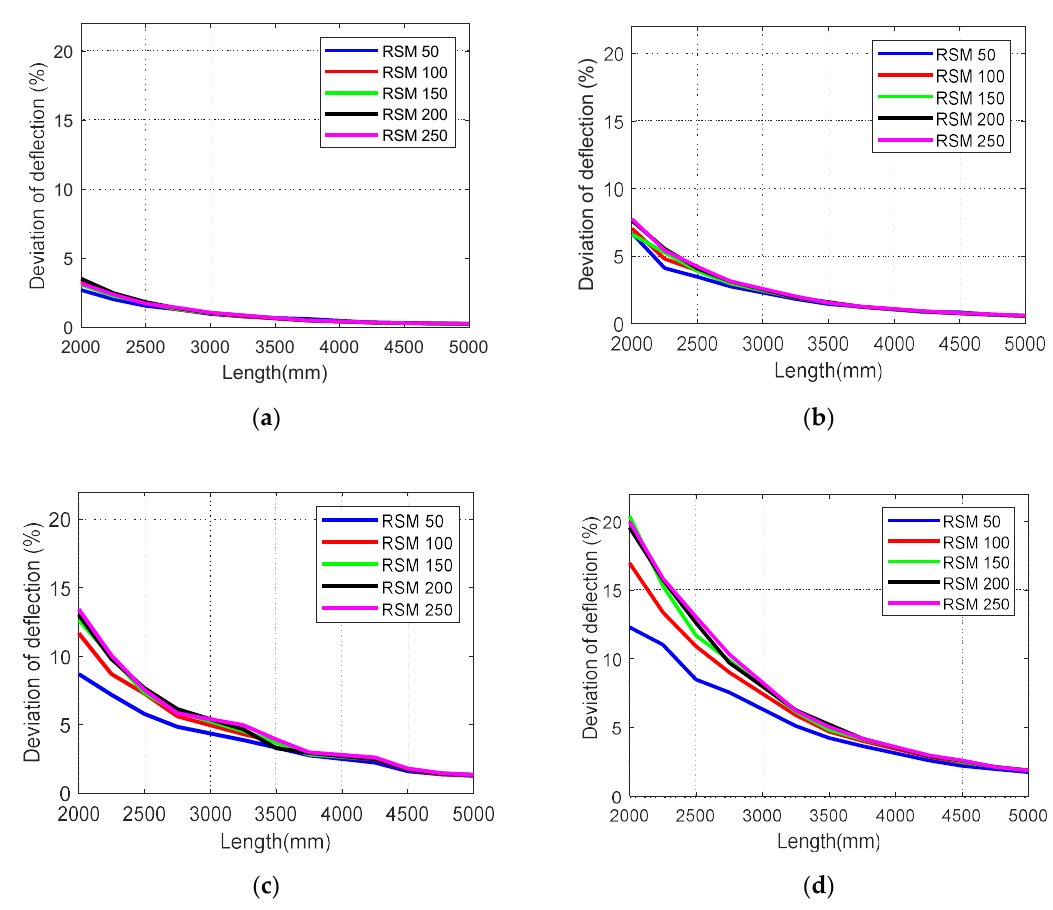
Figure 7. Comparison between FE predictions for CLT deflections vs. analytical predictions using Timoshenko method: ( a ) 90 mm thick CLT panels, ( b ) 120 mm thick CLT panels, ( c ) 150 mm thick CLT panels and ( d ) 180 mm thick CLT panels